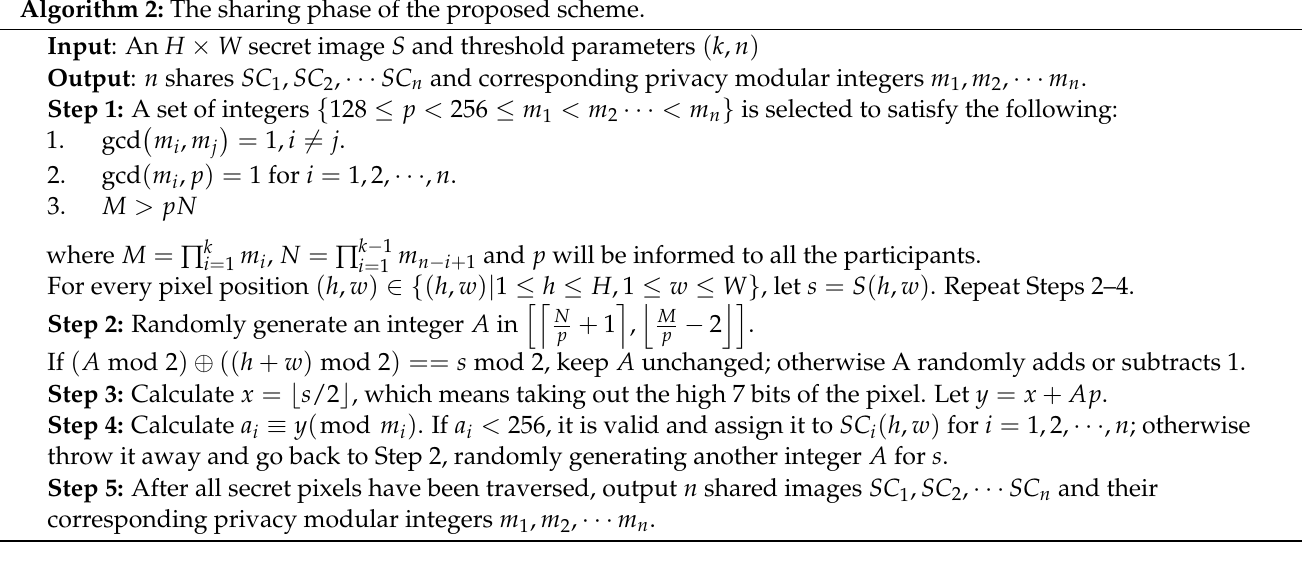
Algorithm 3: The recovery phase of the proposed